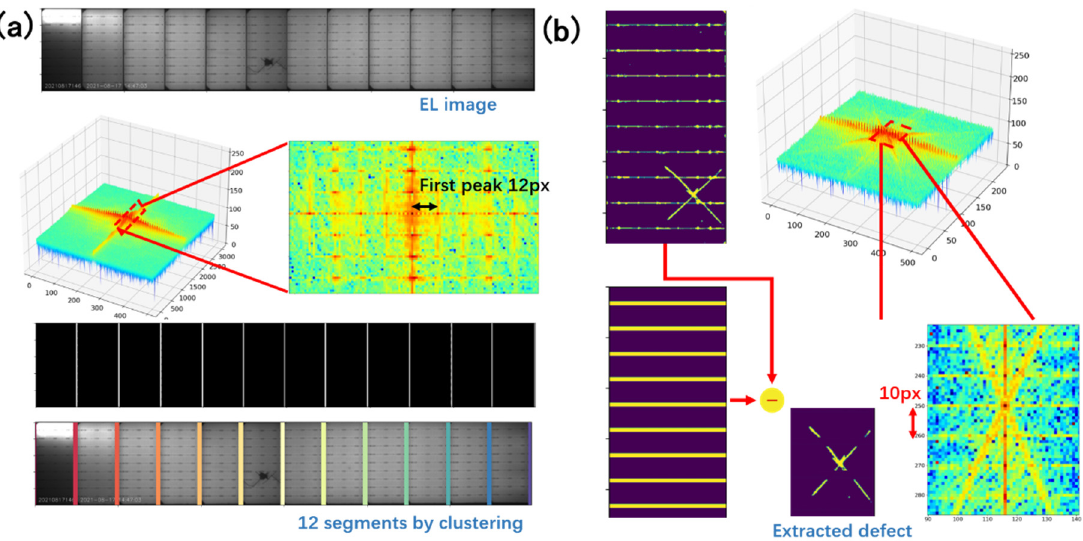
Figure 5. ( a ) The resulting spectrum of the Fourier transform, with the origin point shifted to center; ( b ) vertical reconstruction and defect extraction process.